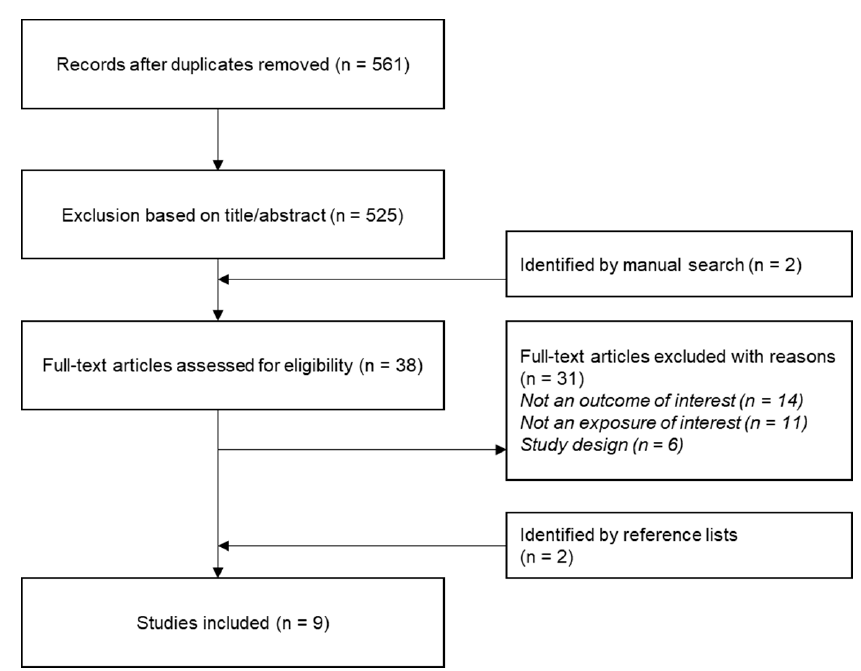
Figure 1. Flow chart describing the selection process in the systematic literature search. Table 2. Food groups associated with metabolites in at least two independent observational studies (table includes search results up to 16 December 2019).